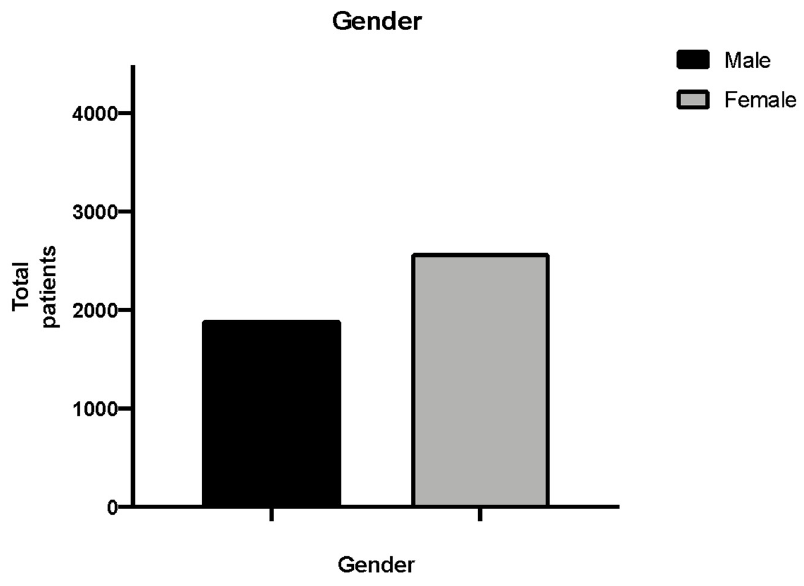
Figure 1. Gender Figure 1. Gender distribution.